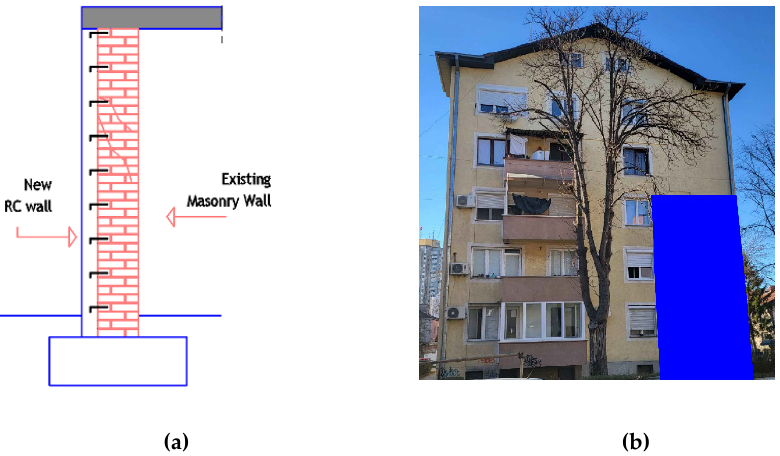
Figure 6. New RC walls: ( a ) a conceptual seismic retrofitting solution showing new RC wall and existing URM wall, and ( b ) a building elevation showing retrofit location.